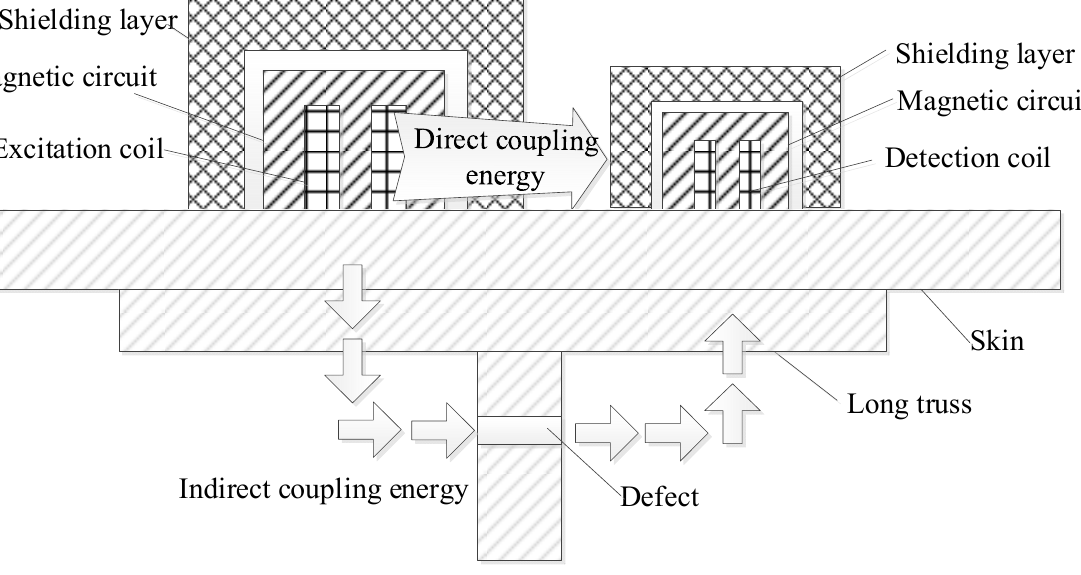
Figure 3. The principle of plane remote field eddy current testing of aircraft long truss structure.